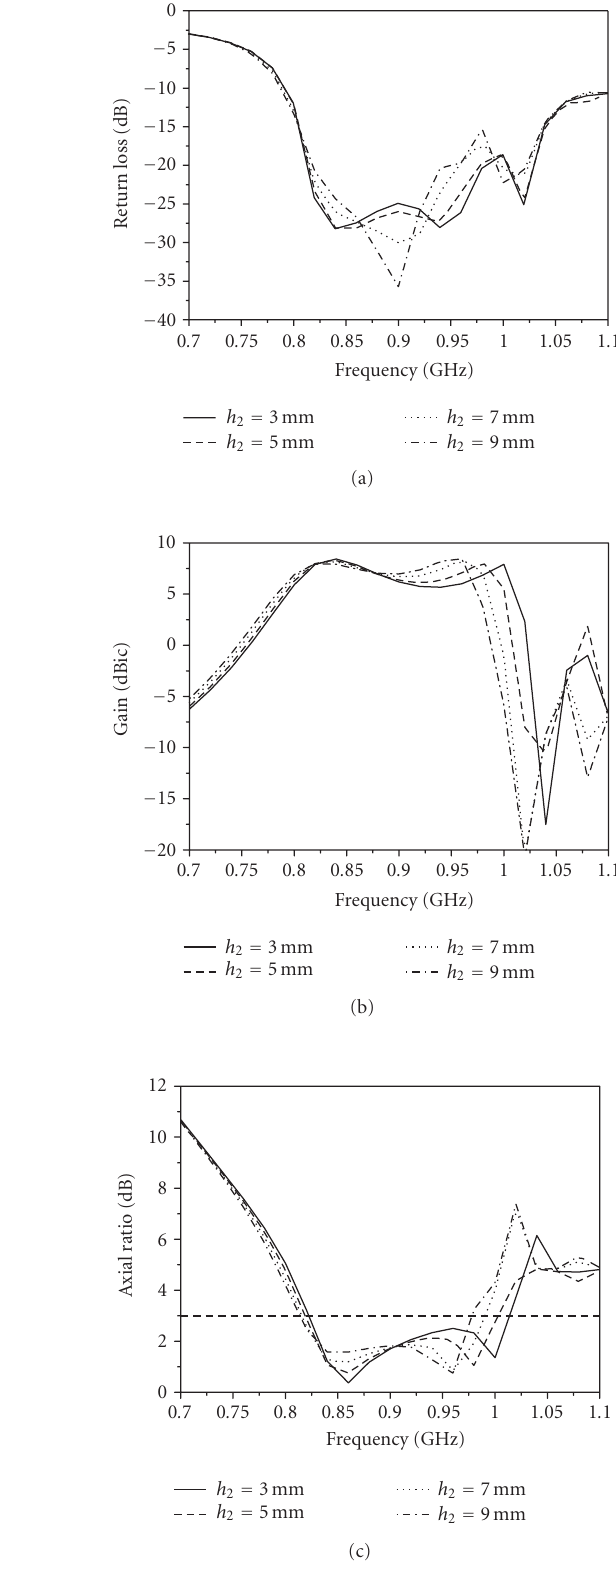
Figure 10: E ff ect of the height of the first stacked patch on the per- formance of the proposed antenna: (a) return loss; (b) gain; (c) axial